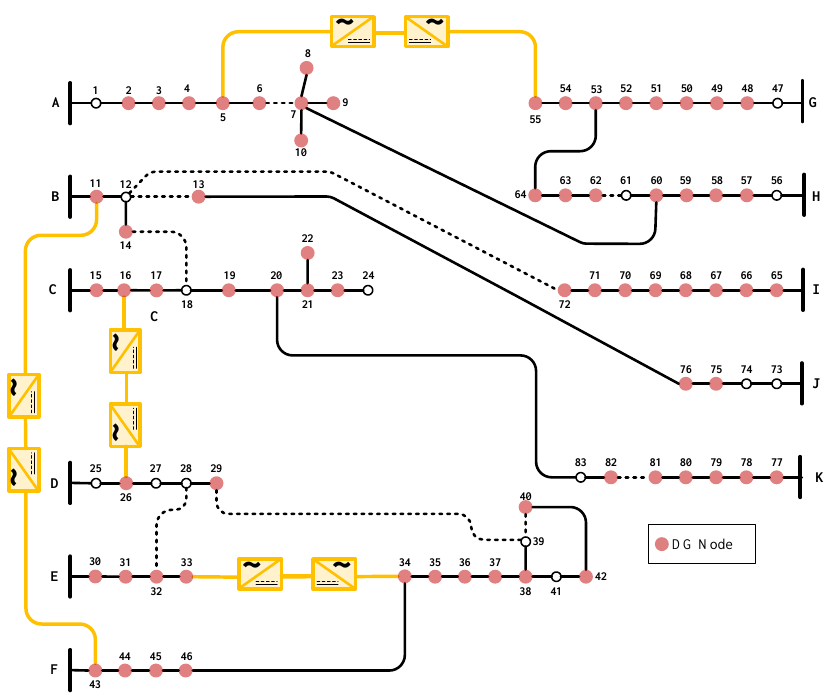
Figure 15. 83-node distribution network after SOPs and DGs allocation.